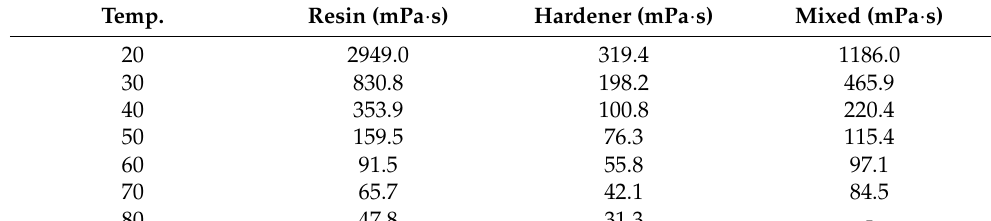
Table 1. Viscosity change of resin, hardener, and mixed resin at different temperatures. Temp.